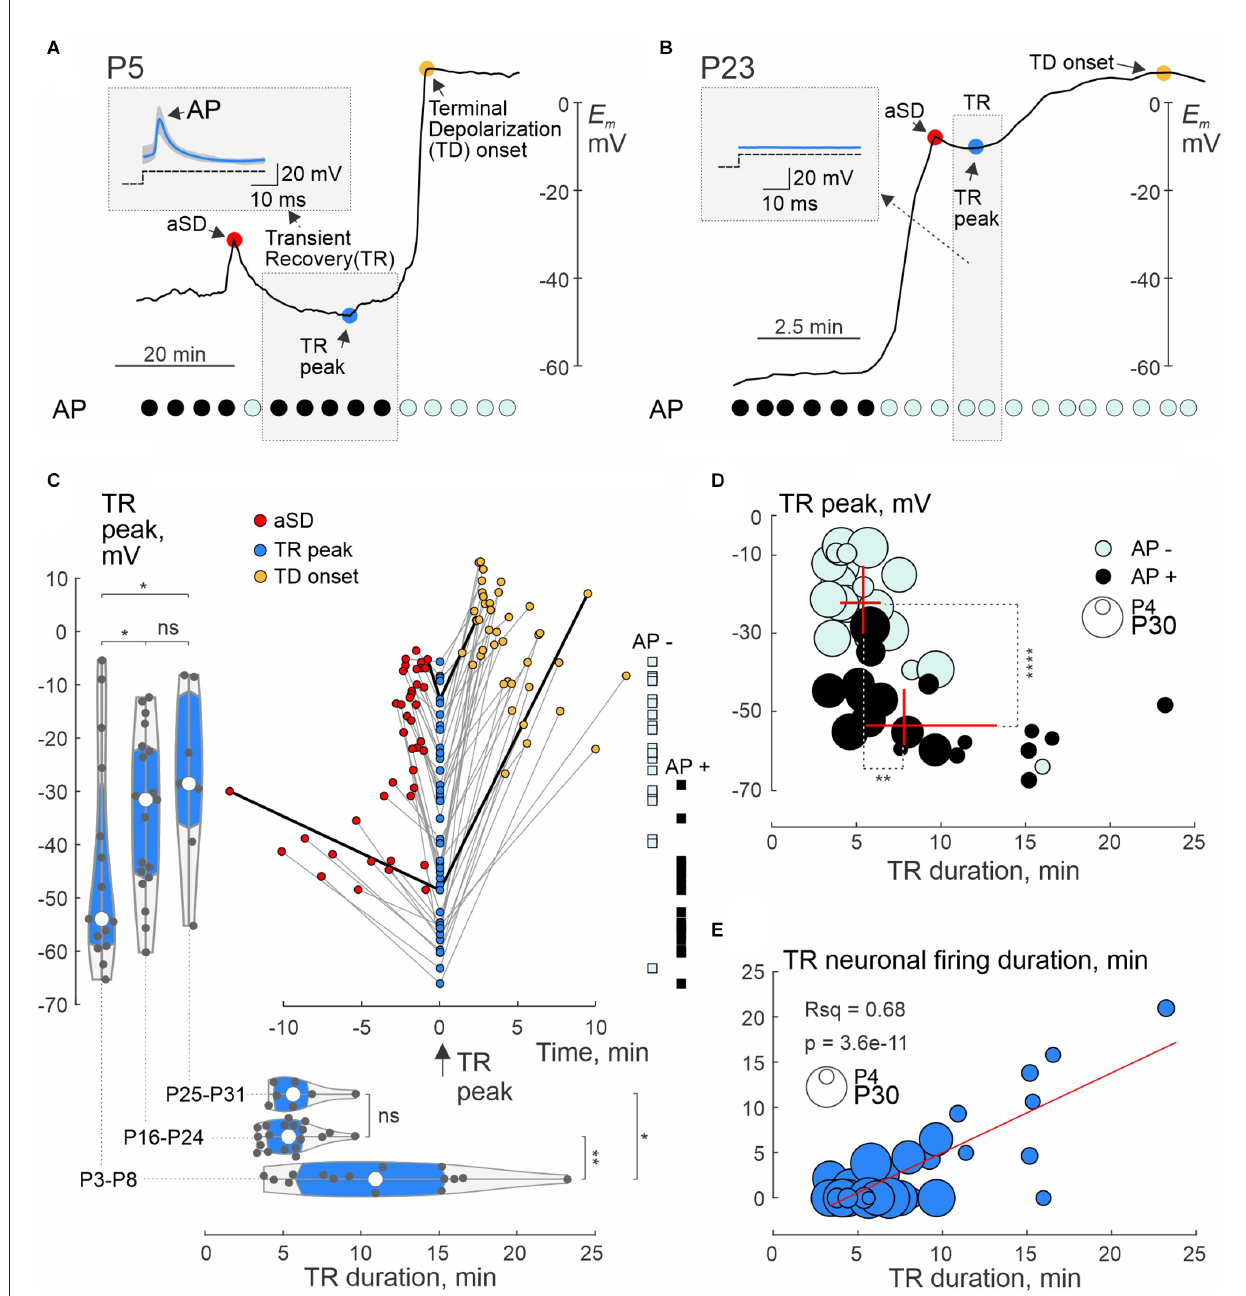
FIGURE5 Postnatal changes in transient membrane potential recovery following aSD. (A,B) Examples of whole-cell recordings from L4 neurons in P5 (A) and P23 (B) rats. Red circle—peak aSD; blue circle—peak negativity during TR; TD—terminal depolarization. Top left insets—mean responses to depolarizing current steps during TR (median blue traces are superimposed on all gray traces). At the bottom are corresponding graphs indicating responses with APs (black circles) and without APs (cyan circles). Note the long TR with preservation of APs after a small aSD at P5, and weak short TR without APs at P23. (C) Summary plot of E m values achieved during TR, aSD, and TD in individual cells. The peak of negativity during TR is taken as a time reference point. TR, aSD, and TD from individual neurons are connected by gray lines, and values connected by black lines correspond to the examples shown in panels (A) and (B) . The left and bottom histograms show the distribution of maximum E m negativity achieved during TR and TR duration, respectively, in the three age groups. On the right, the distribution of TR— E m values according to the absence (AP − , cyan squares) and presence (AP+, black squares) of APs during TR. (D) Relationship between the TR— E m level and duration of TR as well as neuronal firing during the TR phase. Black (AP+) and cyan (AP − ) circles indicate cells that showed or did not show APs in response to depolarizing steps during the TR phase, respectively. The age of the animal is coded by the size of the circle. The red crosses show the median ± interquartile range of TR— E m levels and duration of TR in the AP+ and AP − cell groups. Note the presence and longer persistence of neuronal firing in cells with more negative E m values reached during the TR phase. (E) The duration of the period within the TR phase, during which neurons retain the ability to fire APs in response to depolarizing steps, correlates with the duration of TR. The red line shows a linear regression fit. (C–E) : Pooled data from P3 to P8 ( n = 15), P16–P23 ( n = 19) and P25–P31 ( n = 7). Seventeen cells without TR were excluded from the analysis. *, P < 0.05; **, P < 0.01; ****, P < 0.0001; ns, not significant (Wilcoxon rank sum